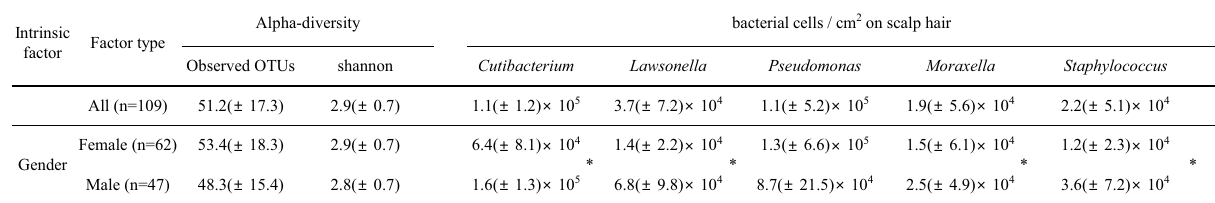
Table 3. Alpha diversity and absolute number of the major bacterial genera between genders. p value more than 0.05 was showed no significant different. * indicates significantly high numbers between female and male.